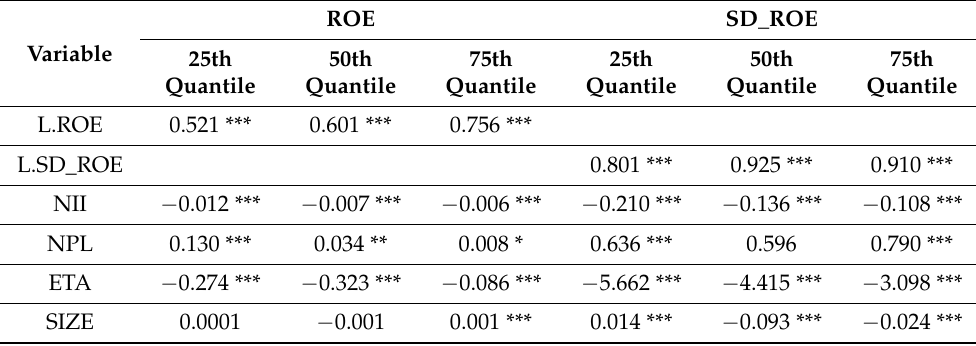
Table 9. Quantile regression results model the impact of non-interest income on the performance of commercial banks. ROE SD_ROE Variable